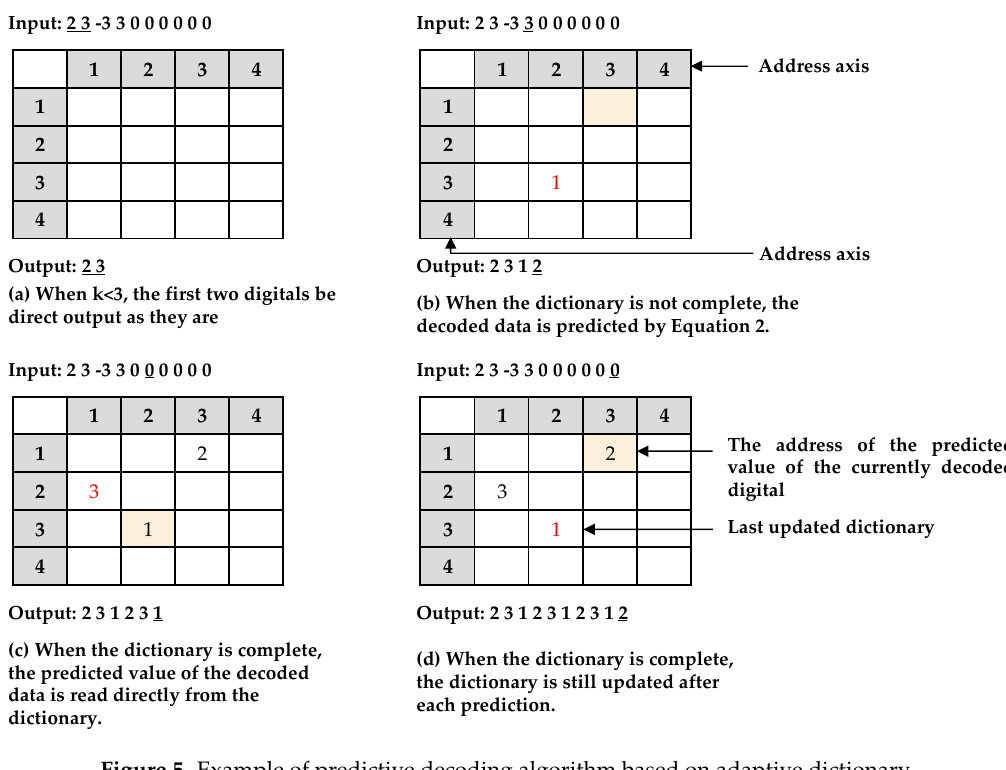
Figure 5. Example of predictive decoding algorithm based on adaptive dictionary.